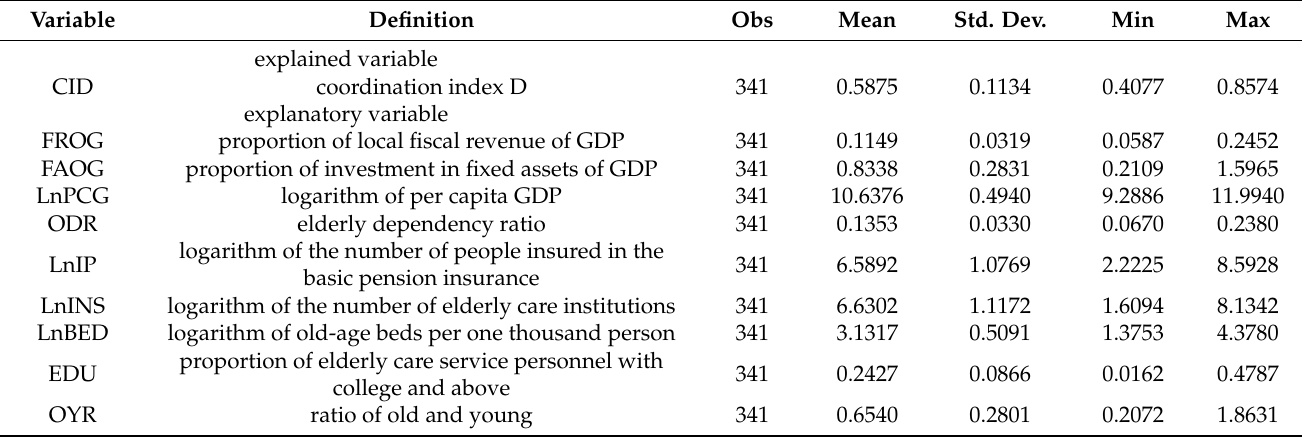
Table 5. Descriptive statistics of variables.